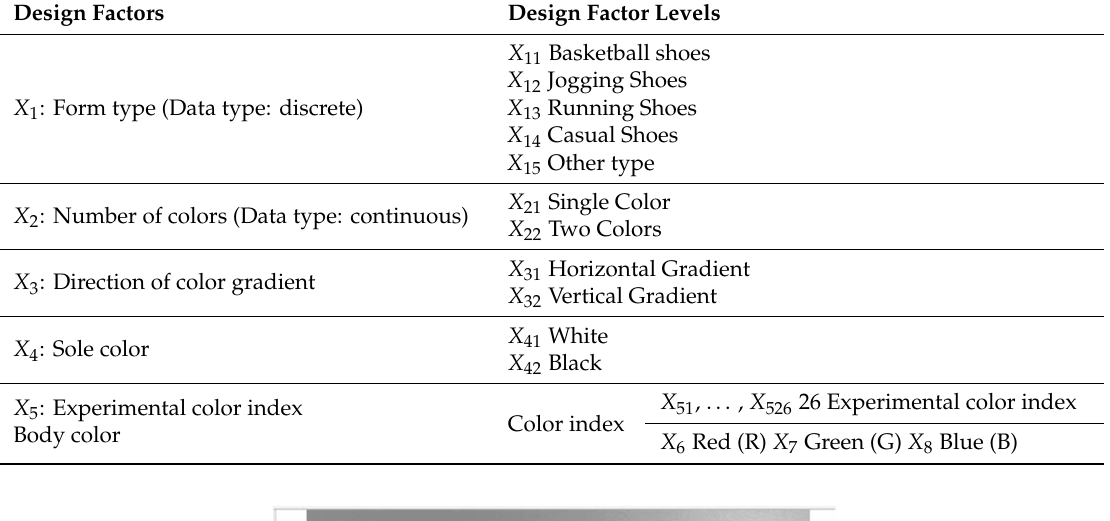
Table 4. Design factors and design factor levels for product forms of sports shoes.